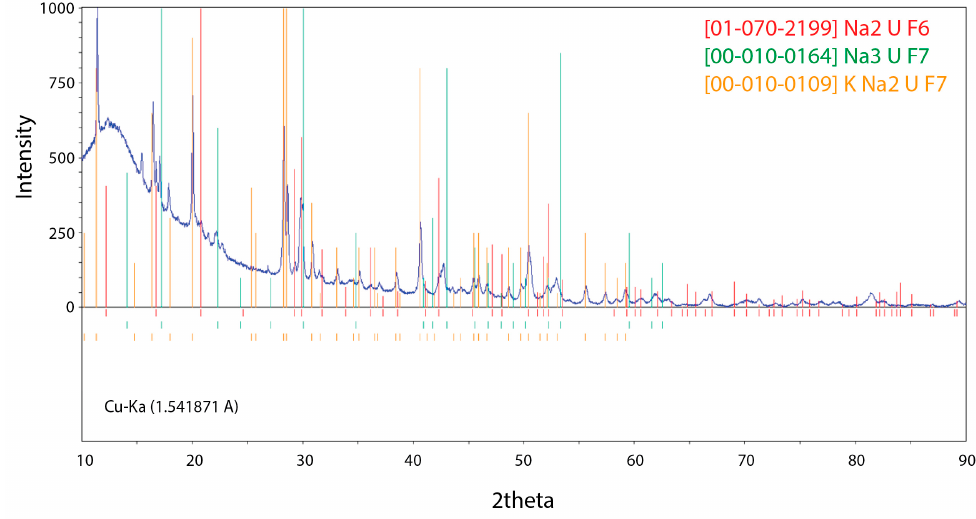
Figure 6. XRD pattern of the NaF-KF-UF 4 (52.3-18.7-29.0 mol%) pseudo-ternary mixture measured after the DSC experiment. Qualitative analysis was performed using Match software and PDF2 database to define the nature of phases present in the sample [20,21].